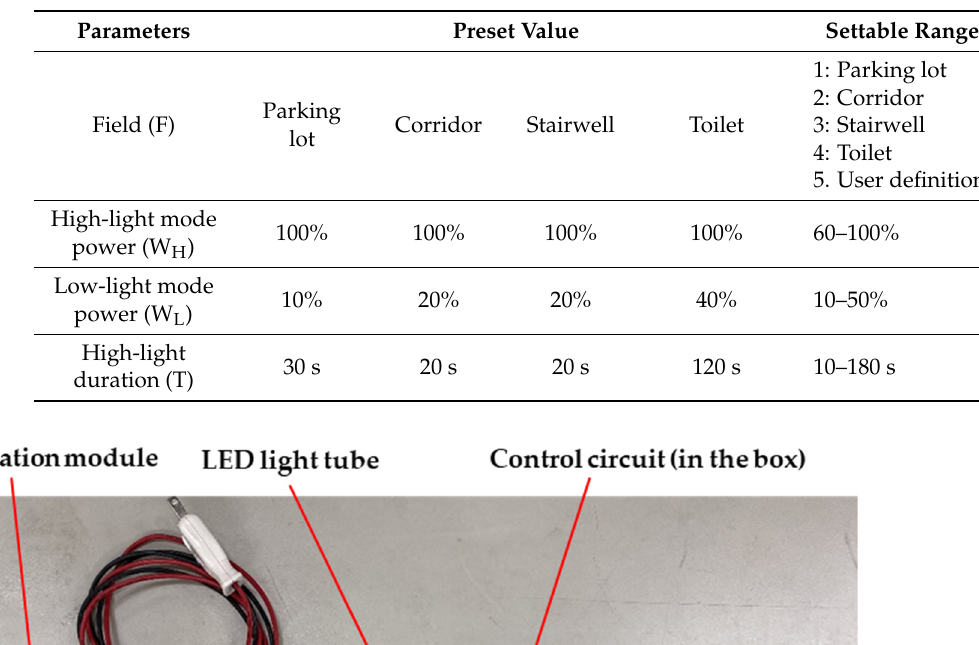
Table 4. An example of the preset values and settable ranges of the proposed IoT-based intelligent LED light parameters.